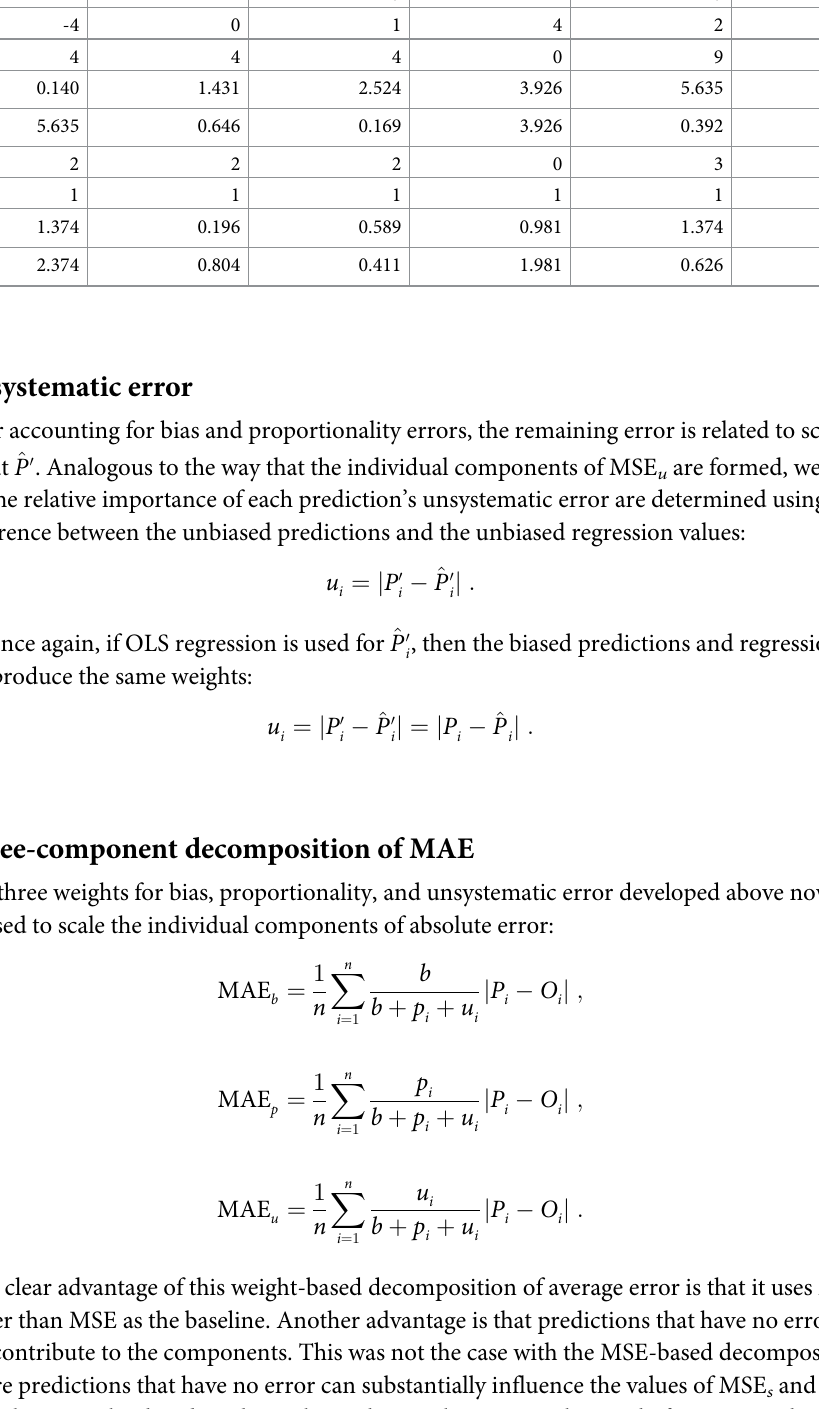
Table 1. Data and error components for the example in Fig 1. For the components whose sum ( S ) is given in the far right column, dividing by 6 gives the mean value (i.e., � O , � P , MSE, MSE s , (MSE u ), and MAE). For the other three rows that have absolute values and are used to form the b , p i , and u i weights, which then determine MAE